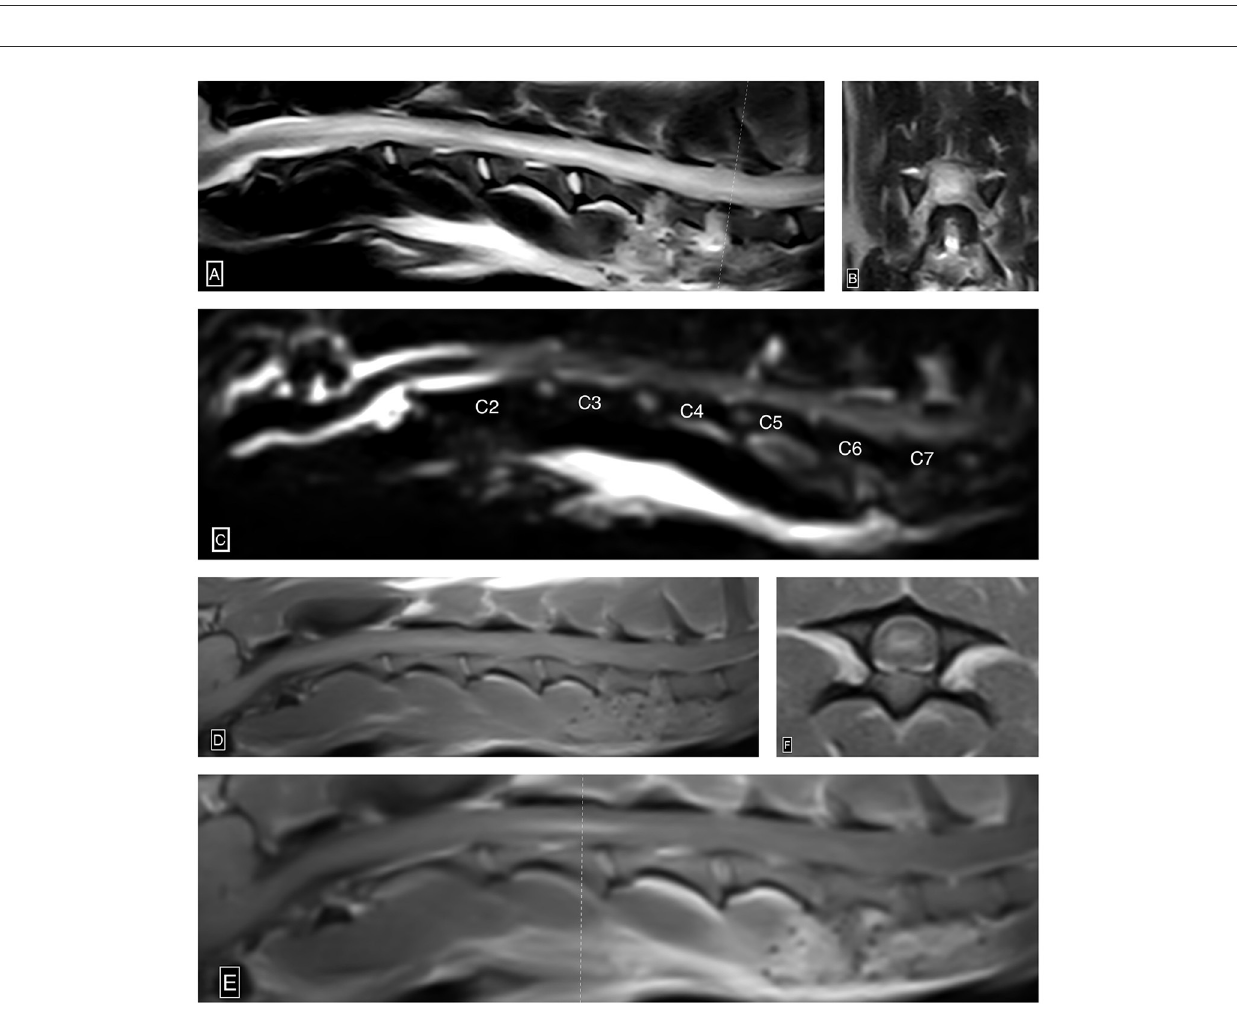
FIGURE2 Ascending/descending cervical myelomalacia. Sagittal (A) and transverse (B) T2W images show severe diffusely and heterogeneously increased intramedullary T2W signal intensity within the cervical spinal cord centered over the gray matter. Notably, the recent C5-6 and C6-7 hemilaminectomy sites characterized by ostectomy and local soft tissue thickening and increased signal intensity (A, B) . Sagittal HASTE image (C) shows complete and circumferential attenuation of the cervical subarachnoid space from the level of mid-C2 beyond the caudal limit of the study (level of T2), suggestive of extensive spinal cord swelling. Pre-contrast sagittal T1W (D) , post-contrast sagittal T1W (E) , and post-contrast transverse T1W (F) images demonstrate ill-defined and heterogeneous intraparenchymal contrast enhancement centered over the gray matter from the level of C2-3 through mid C4. The dotted line (E) denotes the axis by which the post-contrast T1W image is acquired.